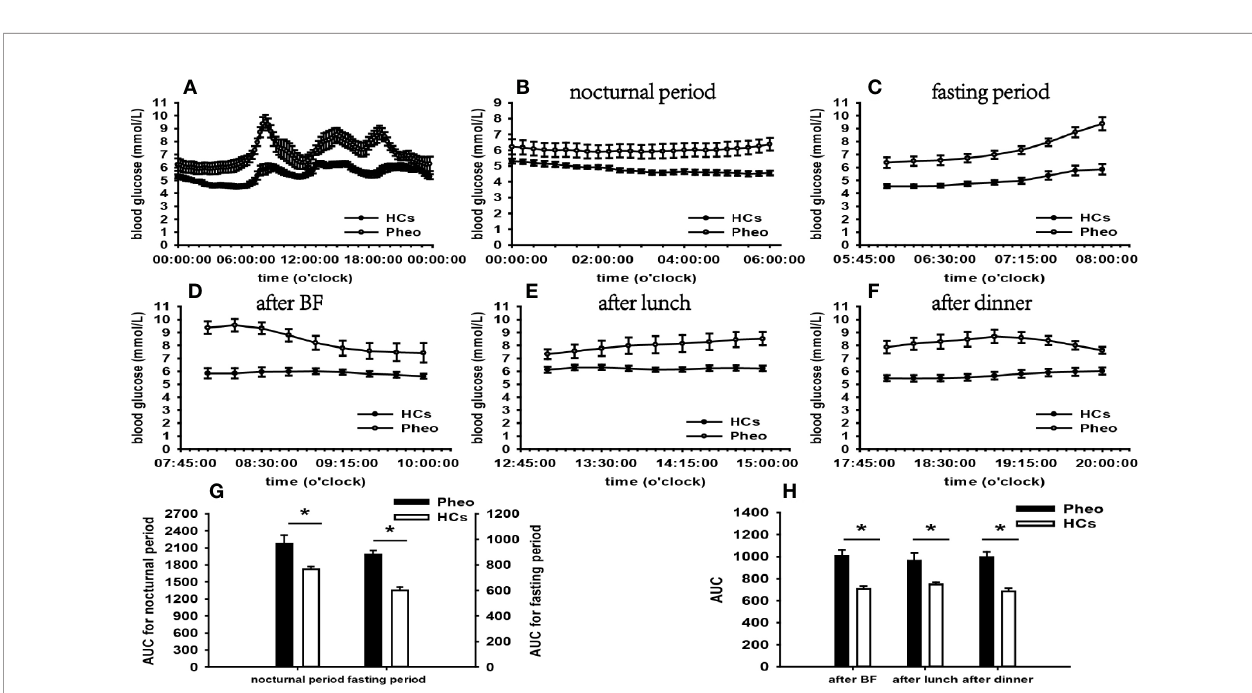
FIGURE 4 | Comparison of the mean blood glucose level and AUC between the Pheo group and HCs. Mean blood glucose level: (A) at each time point during the day; (B) at nocturnal period; (C) at fasting period; (D) after BF; (E) after lunch; (F) after dinner. AUC: (G) at nocturnal and fasting periods; (H) at postprandial periods. * represents signi fi cant difference between Pheo and HCs. The data showed as mean ± SEM. AUC, area under the curve; Pheo, pheochromocytoma; HCs, healthy controls; BF, breakfast; SEM, standard error of